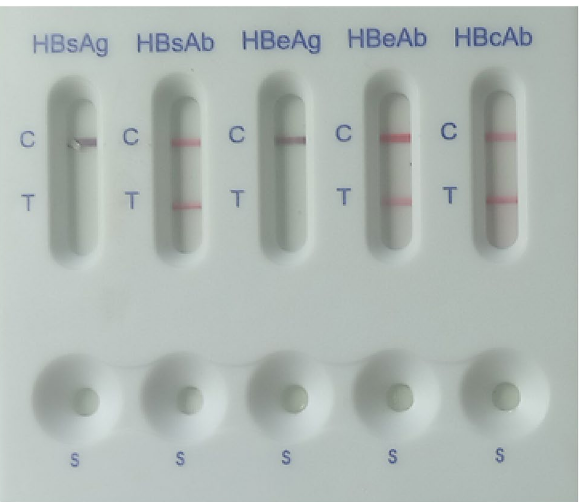
Figure 2. Representative results of the one step hepatitis B virus combo test cassette for the HBV serological markers among the HBsAg negative